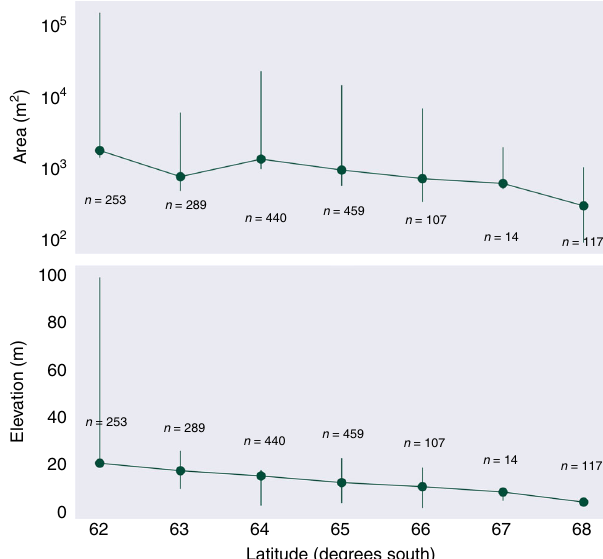
Fig. 5 Spatial trends of green snow algae. Mean green bloom area averaged per degree latitude with logarithmic area scale. Mean bloom elevation above sea level averaged per degree latitude. Error bars report range (minimum and maximum